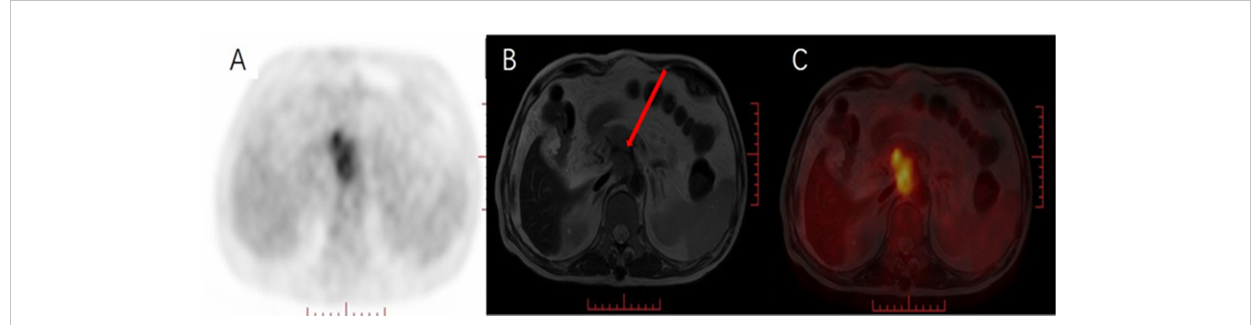
FIGURE 3 Male, 69 years old, with pancreatic cancer. (A) PET MIP image, heterogeneous hypermetabolism was seen in the pancreatic head area, (B) MRI T2WI pancreatic head space-occupying boundary was unclear, showing uneven isointensity, (C) PET/MRI fusion images of, and, respectively, pancreas Compared with the pancreatic background, the mass in the head area is inhomogeneous and hypermetabolic. Pancreatic head lesions compress the hepatic artery, but the course of the hepatic artery is clearly visible (red